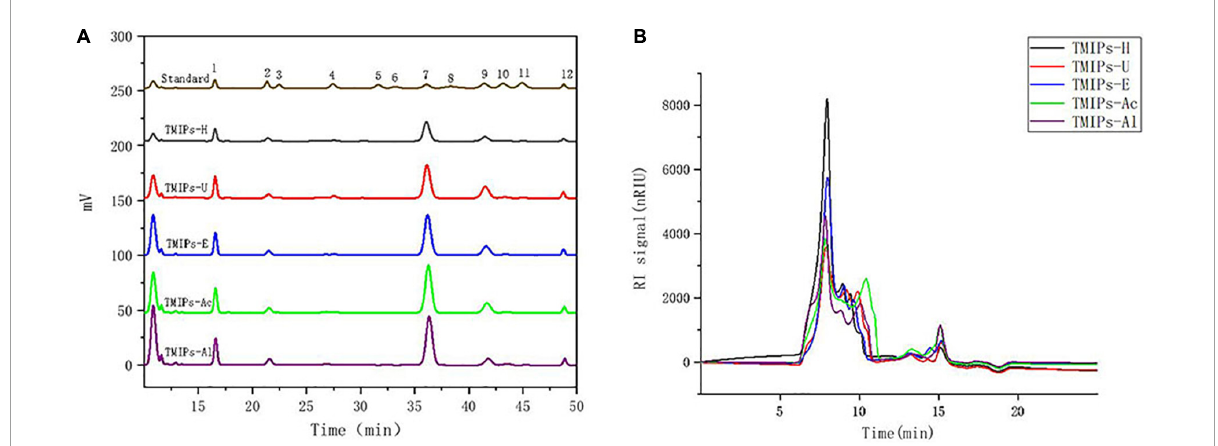
FIGURE1 HPLC chromatograms of PMP derivatives of standard monosaccharides and TMIPs (A) ; 1 – mannose; 2 – ribose; 3 – rhamnose; 4 – glucuronic acid; 5 – galacturonic acid; 6 – N-acetyl-glucosamine; 7 – glucose; 8 – N-acetyl-galactosamine; 9 – galactose; 10 – xylose; 11 – arabinose; 12 – fucose. Molecular weight distribution curve of TMIPs (B) .